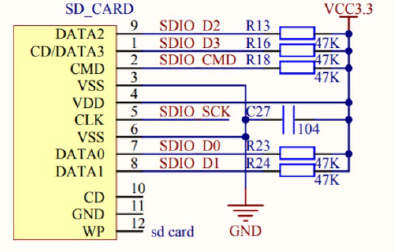
Figure 13. Schematic diagram of audio storage module circuit.